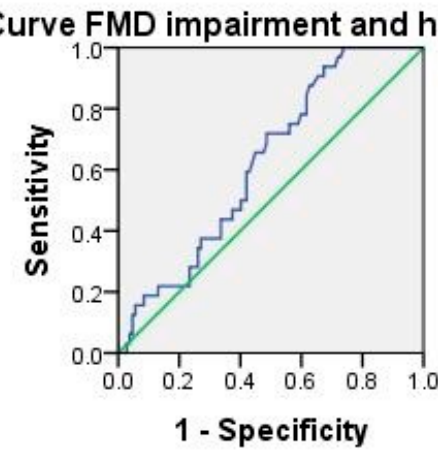
Figure 2. ROC analysis for hsCRP and FMD impairment.